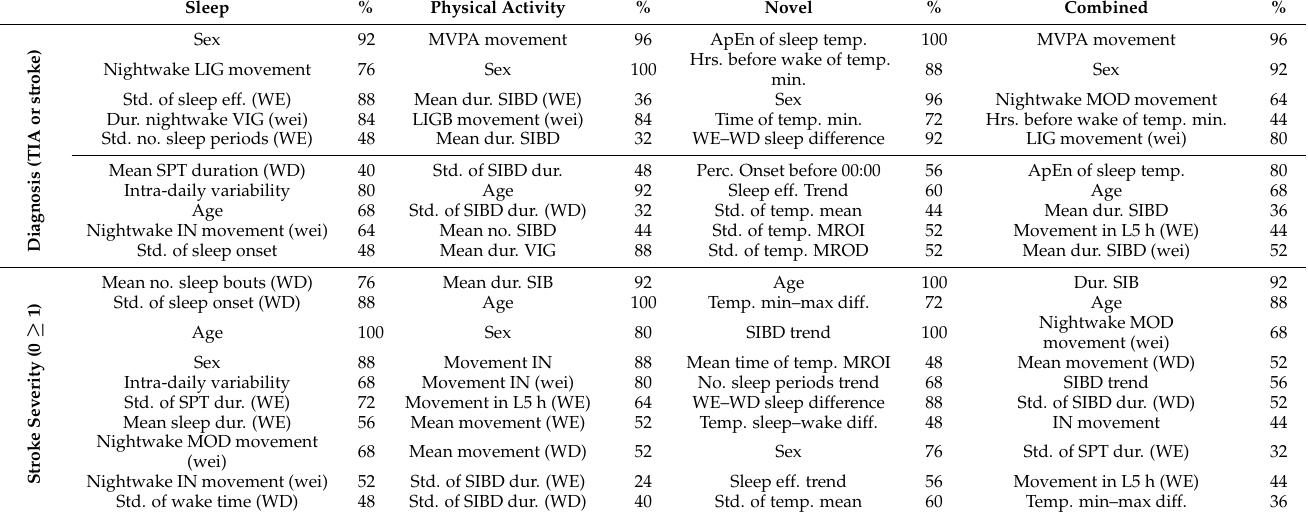
Table 3. The subset of the top 10 selected features using RRCT are presented for estimating diagnosis (upper section) and stroke severity group (lower section) for the respective feature groups (defined by vertical labels). Adjacent to each feature the “stability score” (%) for that feature is presented. Demographics were included in all feature groups prior to feature selection to account for their potential effect on model performance. WD and WE denote weekdays and weekends, respectively. IN denotes inactivity, LIG denotes light activity, MOD denotes moderate activity, VIG denotes vigorous activity, and MVPA denotes moderate to vigorous activity; “wei” indicates a weighted average across available days, with weekend days weighted 2/5 weekdays.